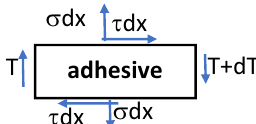
Figure 5: Stress distribution in the adhesive